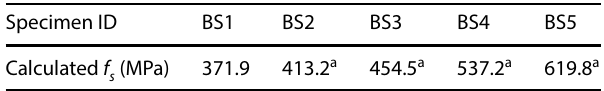
Table 5 Calculated reinforcement stress